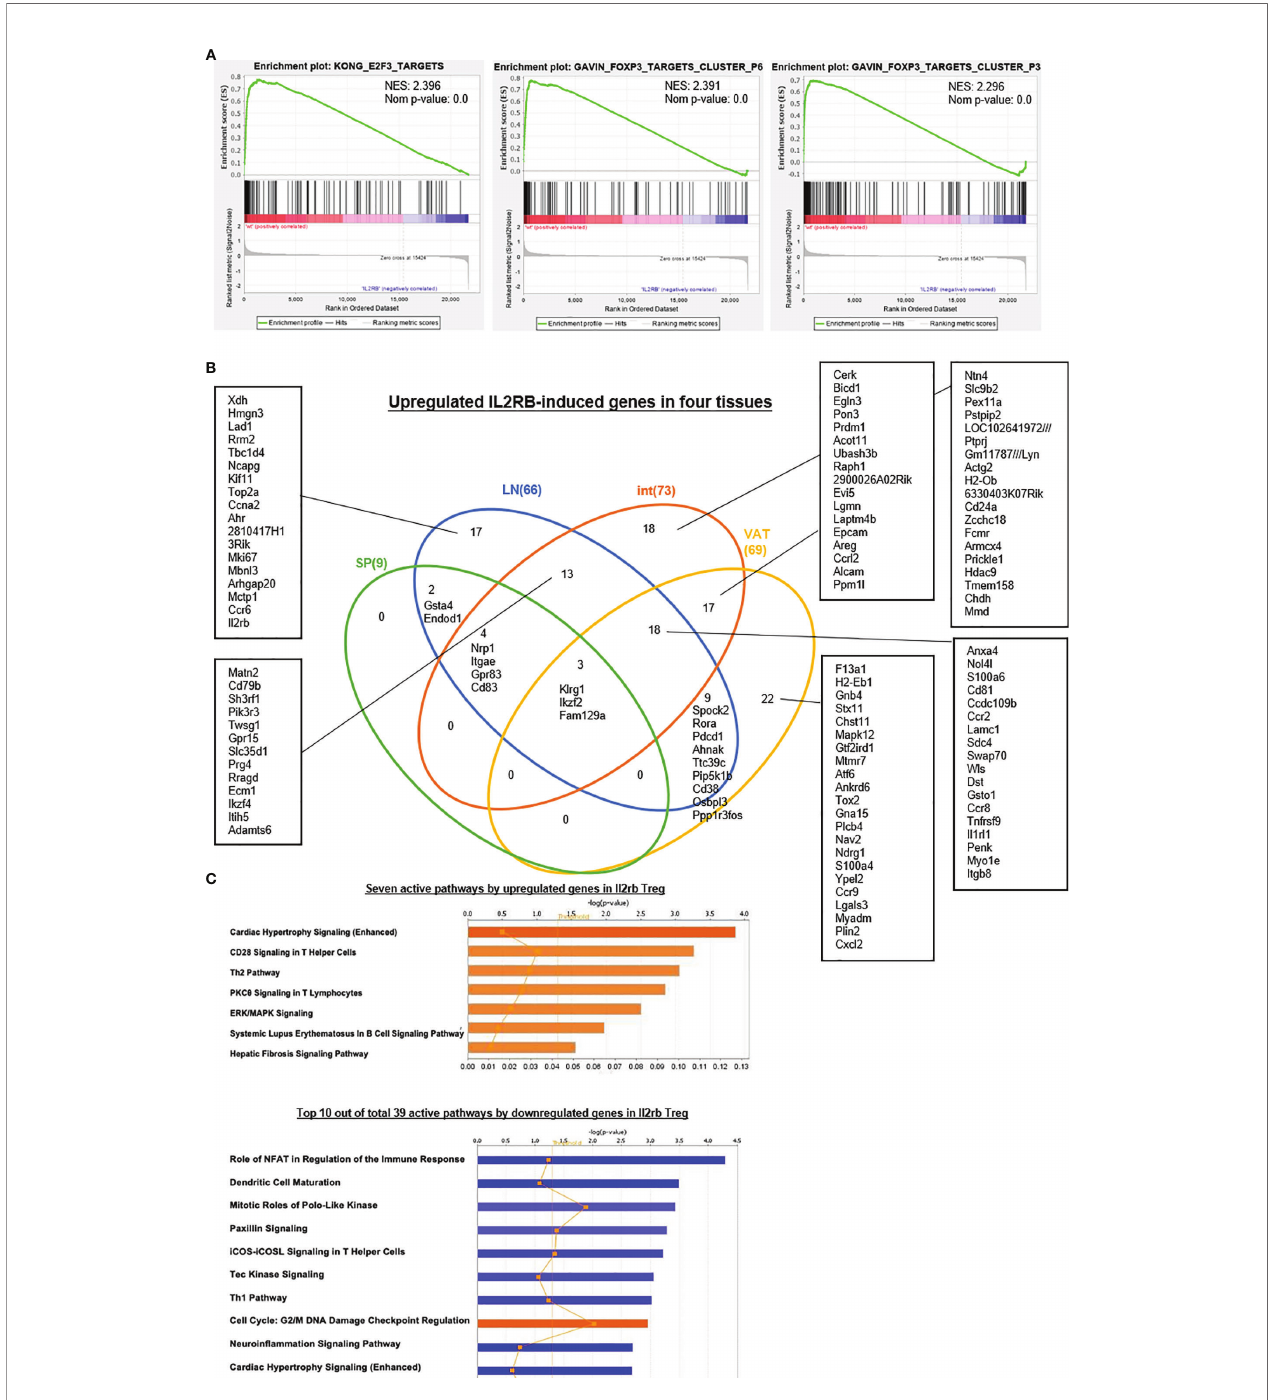
FIGURE 10 | (A) The gene set enrichment analysis (GSEA) were applied to investigate the potential mechanisms that how IL2RB modulates Treg signature genes. We found that Il2rb could suppress the function of E2F3 and FOXP3 and thus modulated Treg. Another interesting fi nding was that Il2rb could suppress some cancer, such as pediatric cancer, liver cancer, and myeloma, indicating its potential role in cancer therapy. (B) Venn Diagram showed shared and tissue-speci fi c IL2RB-induced genes both upregulated and downregulated in four tissues we studied. (C) Active pathways analyzed by IPA indicated that seven pathways were activated by upregulated genes in Il2rb − / − Treg, including Cardiac Hypertrophy Signaling (Enhanced), CD28 Signaling in T Helper Cells, Th2 Pathway, PKC q Signaling in T Lymphocytes, ERK/MAPK Signaling, Systemic Lupus Erythematosus In B Cell Signaling Pathway and Hepatic Fibrosis Signaling Pathway. In addition, 39 pathways were activated by downregulated genes in Il2rb − / − Treg, among which three pathways were positively activated including Cell Cycle: G2/M DNA Damage Checkpoint Regulation, RhoGDI Signaling and Endocannabinoid Cancer Inhibition Pathway. All these results indicated Il2rb may mediate the plasticity of Treg in different